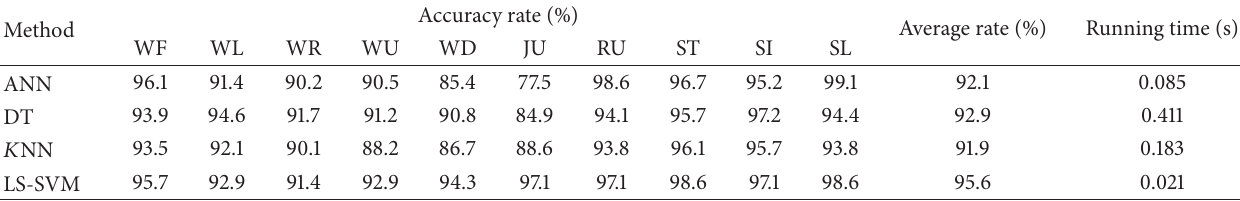
Table 5: Accuracy rates and running times of the classification